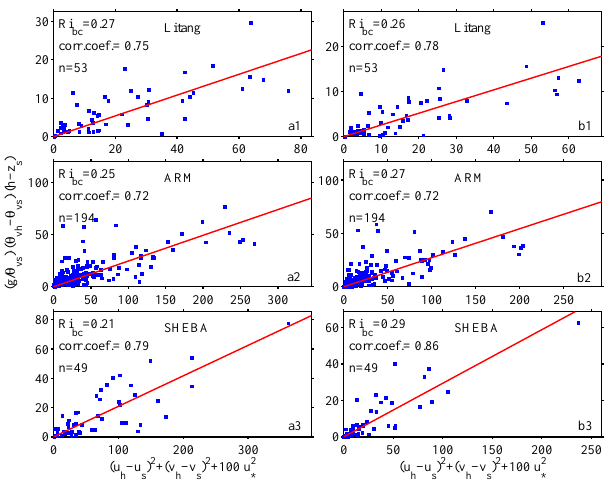
Figure 5. Linear fitting method inferred Ri bc for type II SBLs, with z s = 40m (left) and z s = 80m (right). The red solid lines are the best linear fittings and their slopes represent the values of Ri bc .